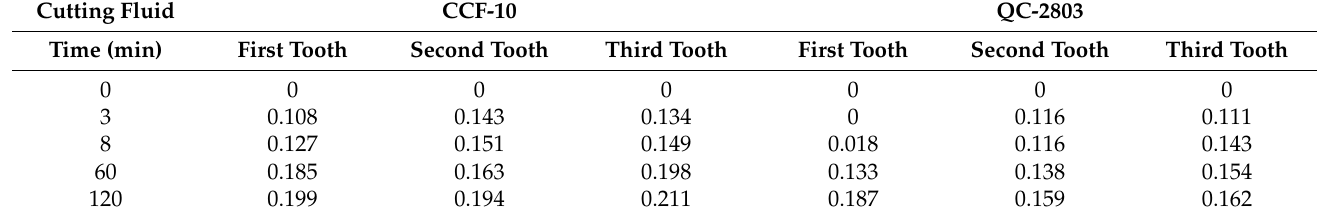
Table 5. Changes in tool wear during milling (mm).